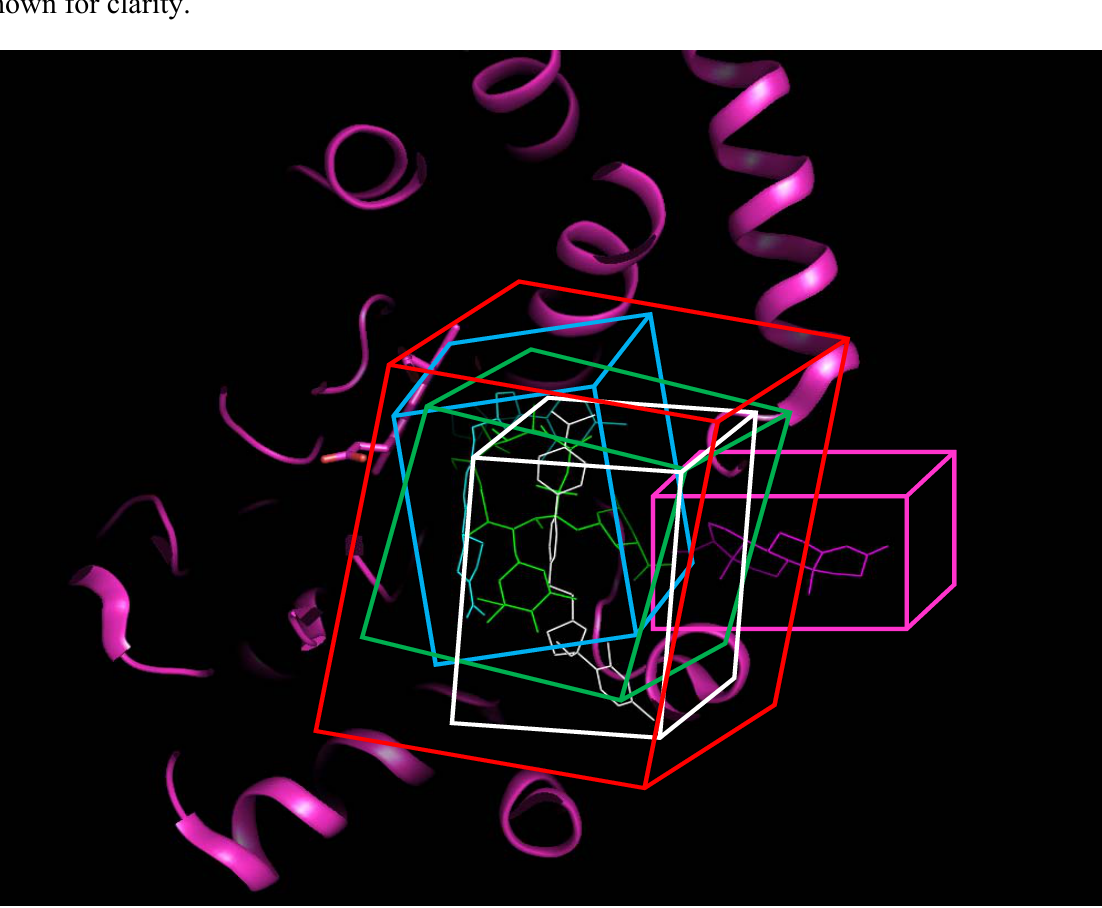
Figure 8. Superimposed docking sites of the human CYP3A4 isozyme. The trace of 1W0F structure (with bound progesterone) is denoted by the magenta ribbon. Each box represents a docking area of interest. The progesterone allosteric binding pocket area at the entrance of the 1W0F active site is represented by the magenta box; the catalytic site area of 2J0D (where erythromycin A is bound) is represented by the green box; the catalytic site area of 2V0M (where one of the ketoconazole molecules is bound) is represented by the cyan box; the auxiliary pocket area in the active site of 2V0M (that holds the second ketoconazole molecule) is represented by the white box; the area of the full active site in 2V0M is represented by the red box. The areas occupied by the catalytic site in 2V0M, 1W0F, and 1TQN structures are almost identical upon superposition. Therefore, the latter two are not shown for